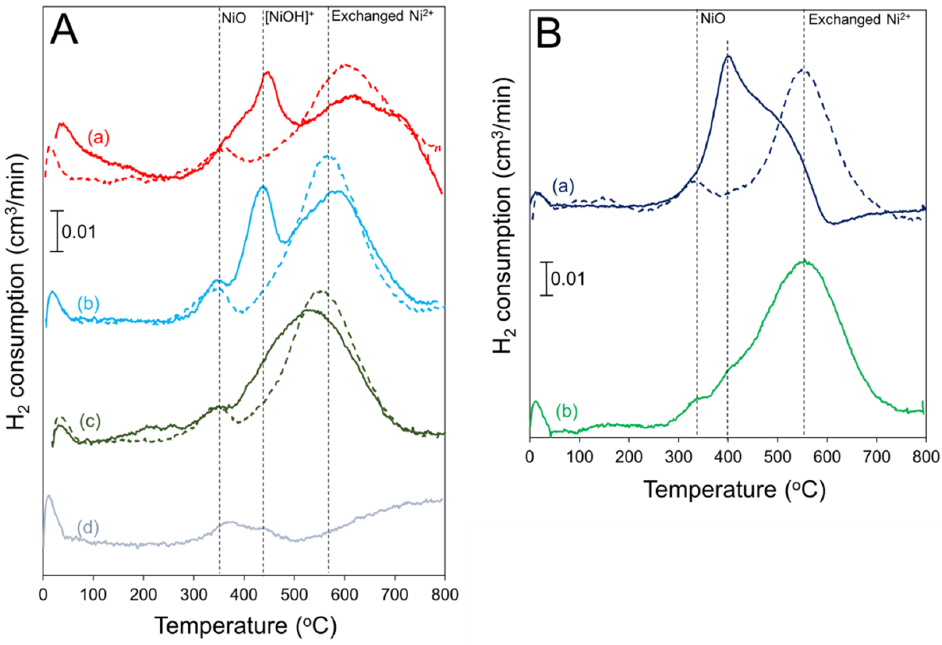
Figure 3. H 2 TPR profiles of catalysts after in situ pretreatment at 300 °C (solid lines) and 500 °C (dashed lines). ( A ) (a) Ni-H-Beta (H + -4x), (b) (H + -3x), (c) (H + -2x), (d) (H + -1x); ( B ) (a) Ni-NH 4 -Beta, (b) Ni-H-Beta (NH 4+ -4x).